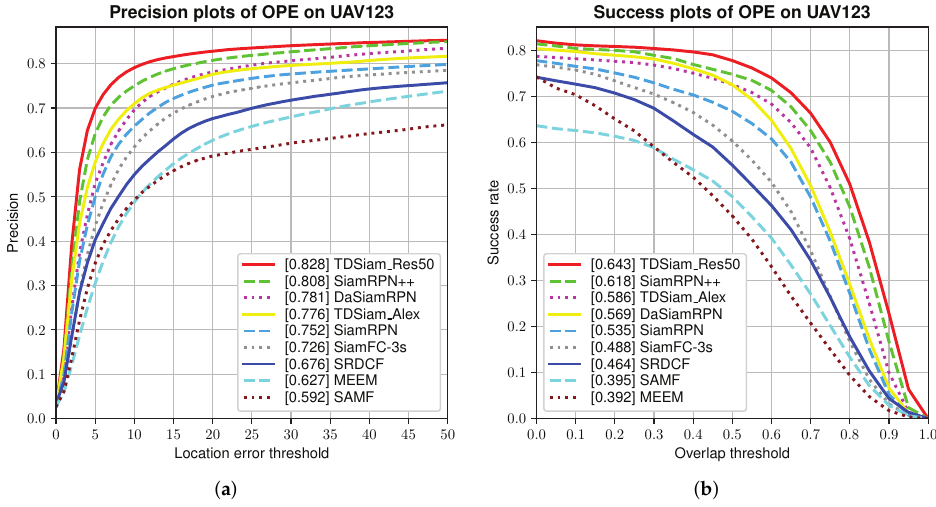
Figure 6. Experimental results of different methods on UAV123 dataset.The proposed algorithm TDSiam_Res50 performs favorably against other trackers. ( a ) Precision plots; ( b ) Success plots.